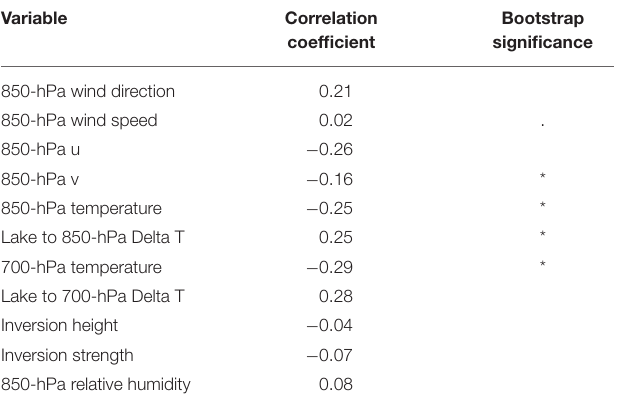
TABLE 5 | Correlation coefficients between peak snowfall and several variables from the upstream sounding at Green Bay, WI, during lake-effect snow days.